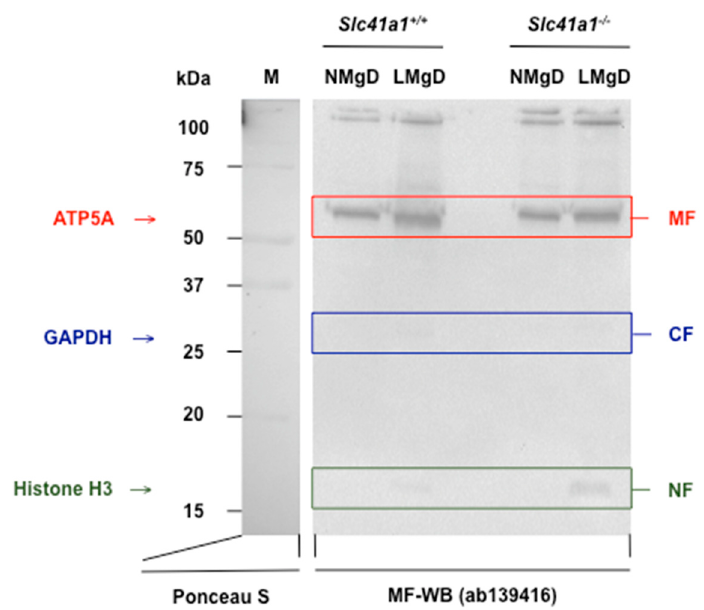
Figure A8. Post-hoc Tukey’s range test/CIII. The CIII activities presented as box-and-whisker plot overlaid with dot plot; dots represent raw input values for each analyzed group ( Slc41a1 − / − animals on LMgD, Slc41a1 +/+ animals on LMgD, Slc41a1 − / − animals on NMgD, and Slc41a1 +/+ animals on NMgD); * p < 0.05, ** p < 0.01. Abbreviations: A1 , Slc41a1 ; CIII, complex III; LMgD, low Mg diet; NMgD, normal Mg diet.